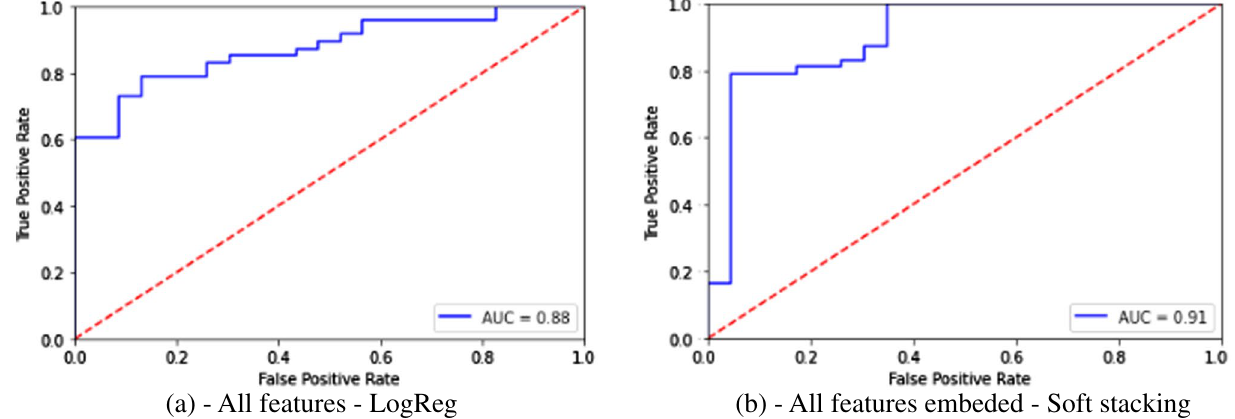
Figure 6. ROC plots for classification using all feature